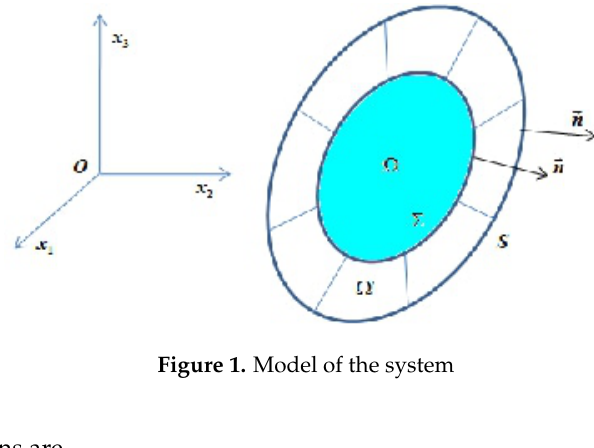
Figure 1. Model of the